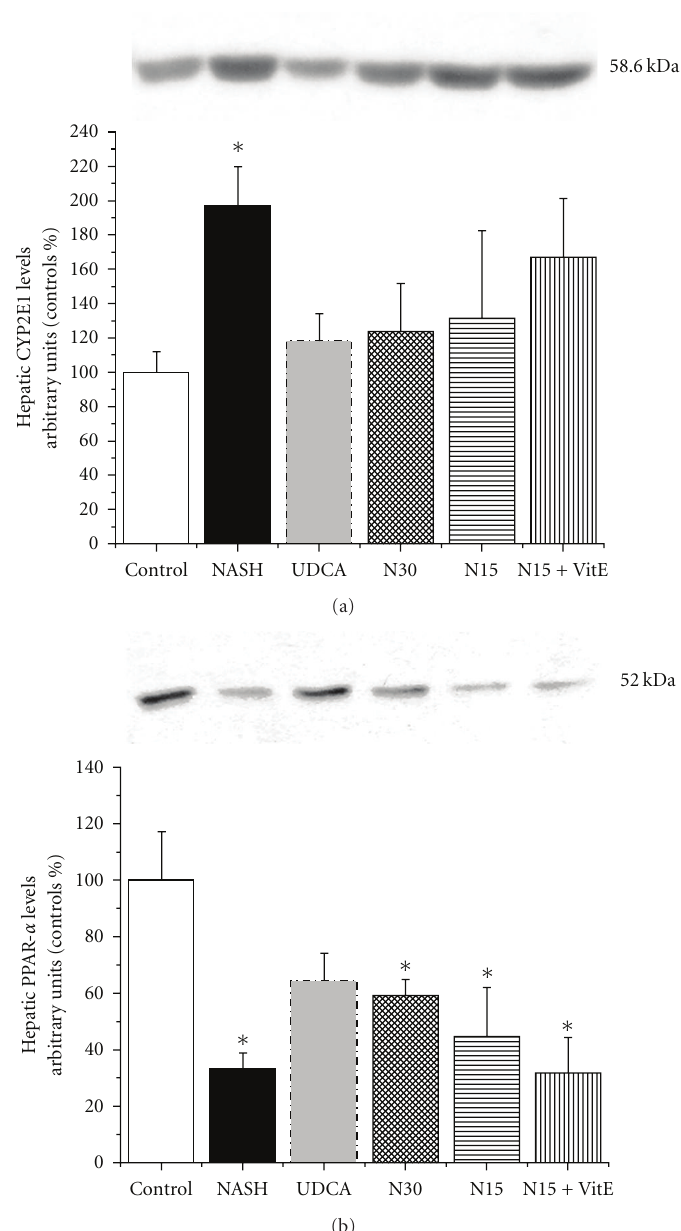
Figure 6: E ff ect of treatments on CYP2E1 and PPAR- α